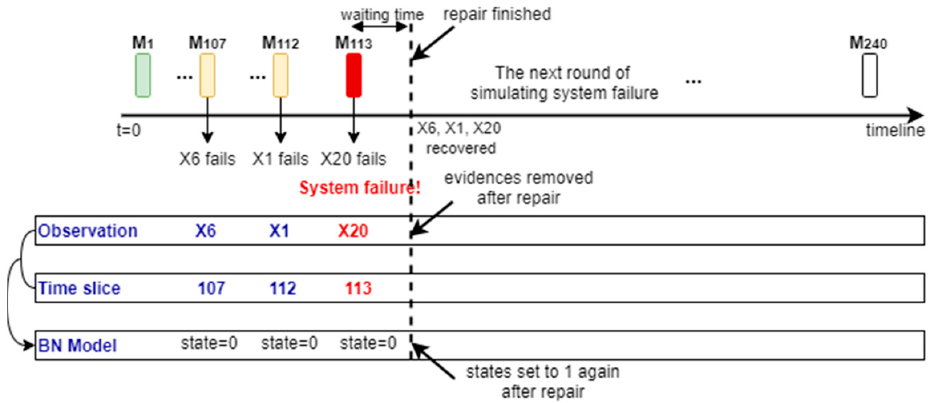
Energies 2020 , 13 , x FOR PEER REVIEW Figure 8. Schematic illustrating how the evidences are considered in the BN model.